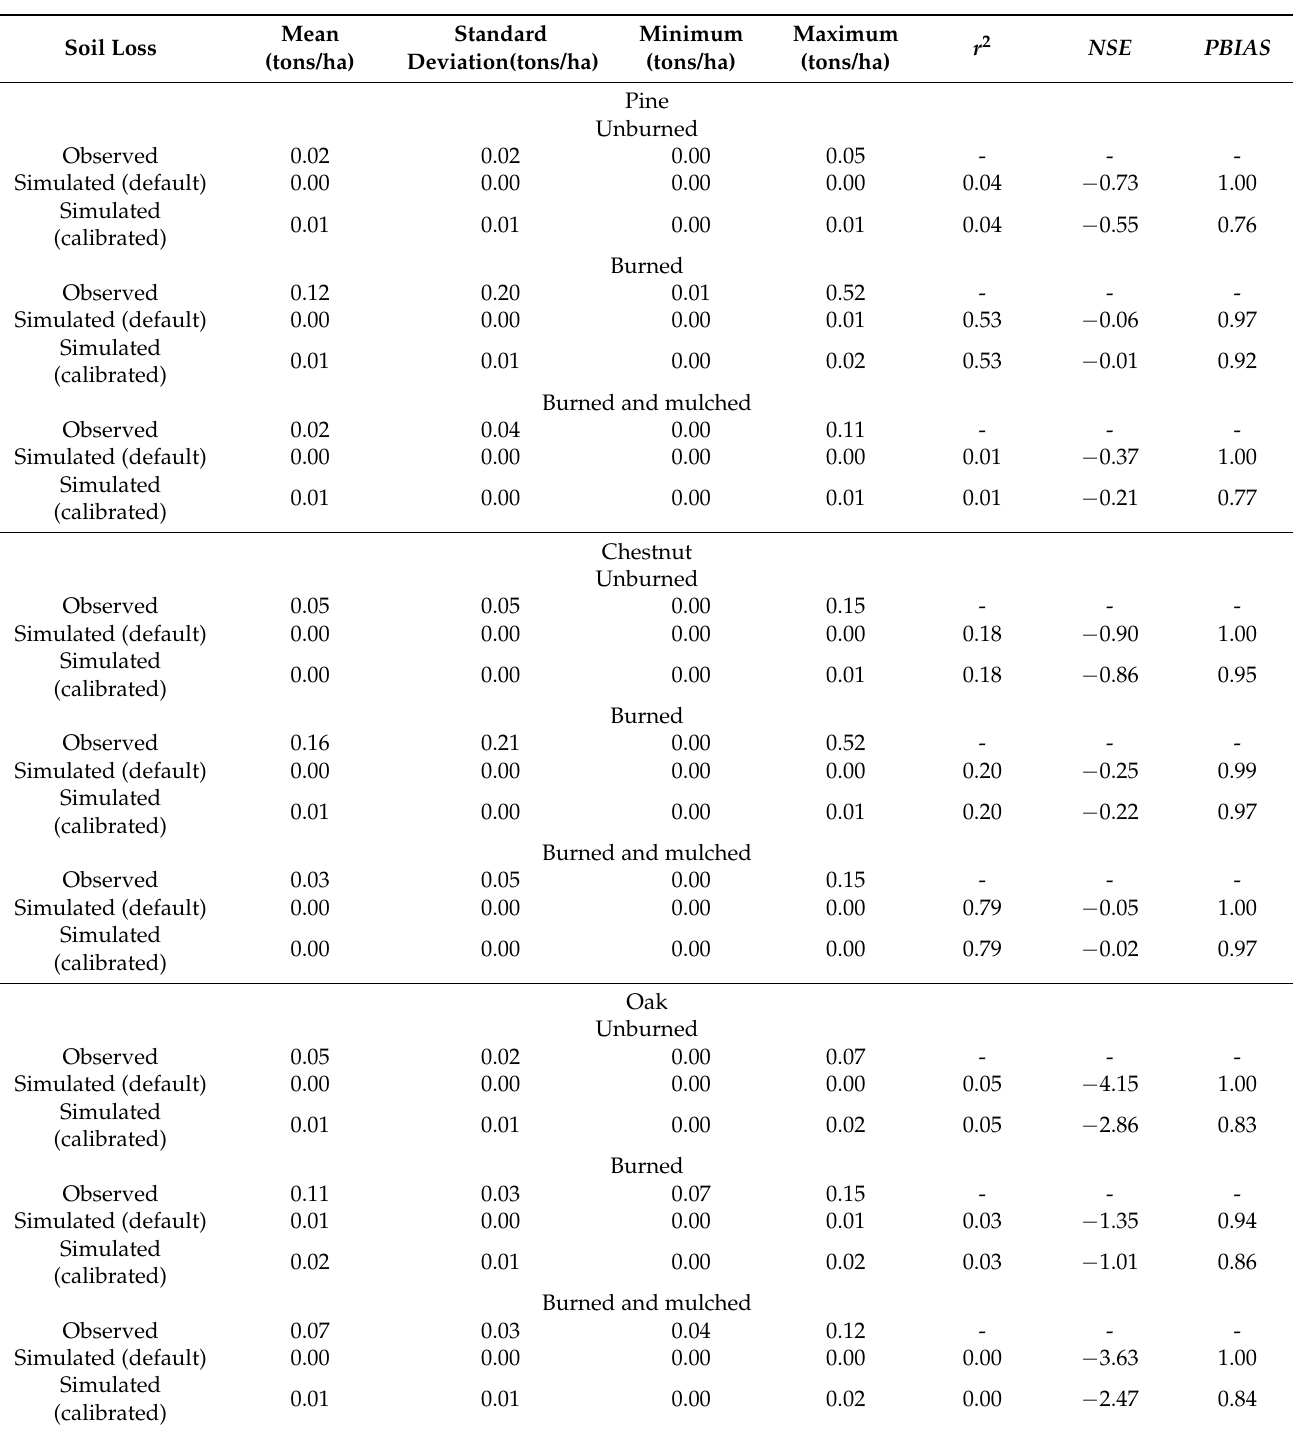
Table 5. Statistics and indexes evaluating the runoff prediction capability of MUSLE model in forest plots subject to prescribed fire and soil mulching with